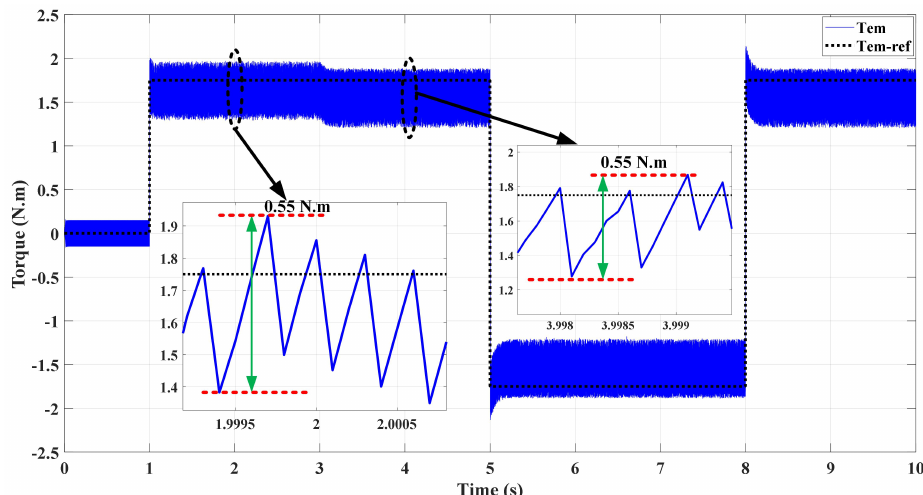
Figure 11. Torque response for the conventional and the improved strategies.